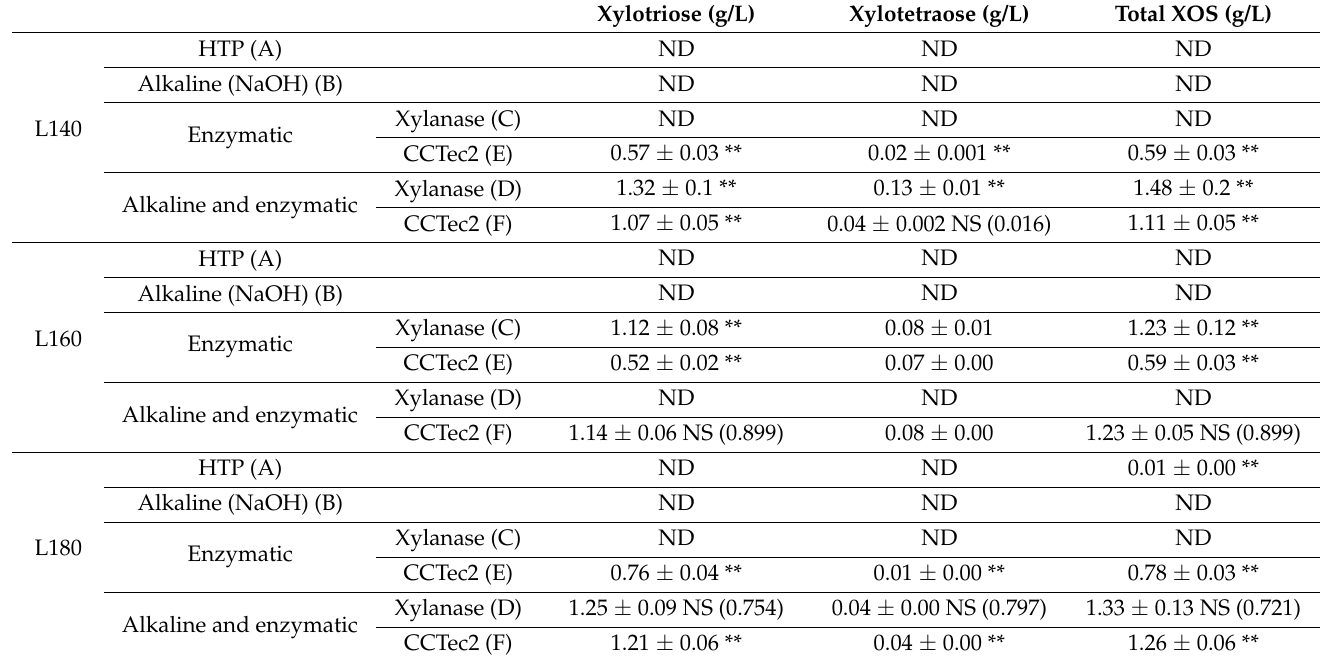
Table 3. Xylo-oligosaccharides yields in the hydrolysates after HTP, alkaline and enzymatic treatments of the solid residues. Xylotriose (g/L) Xylotetraose (g/L) Total XOS